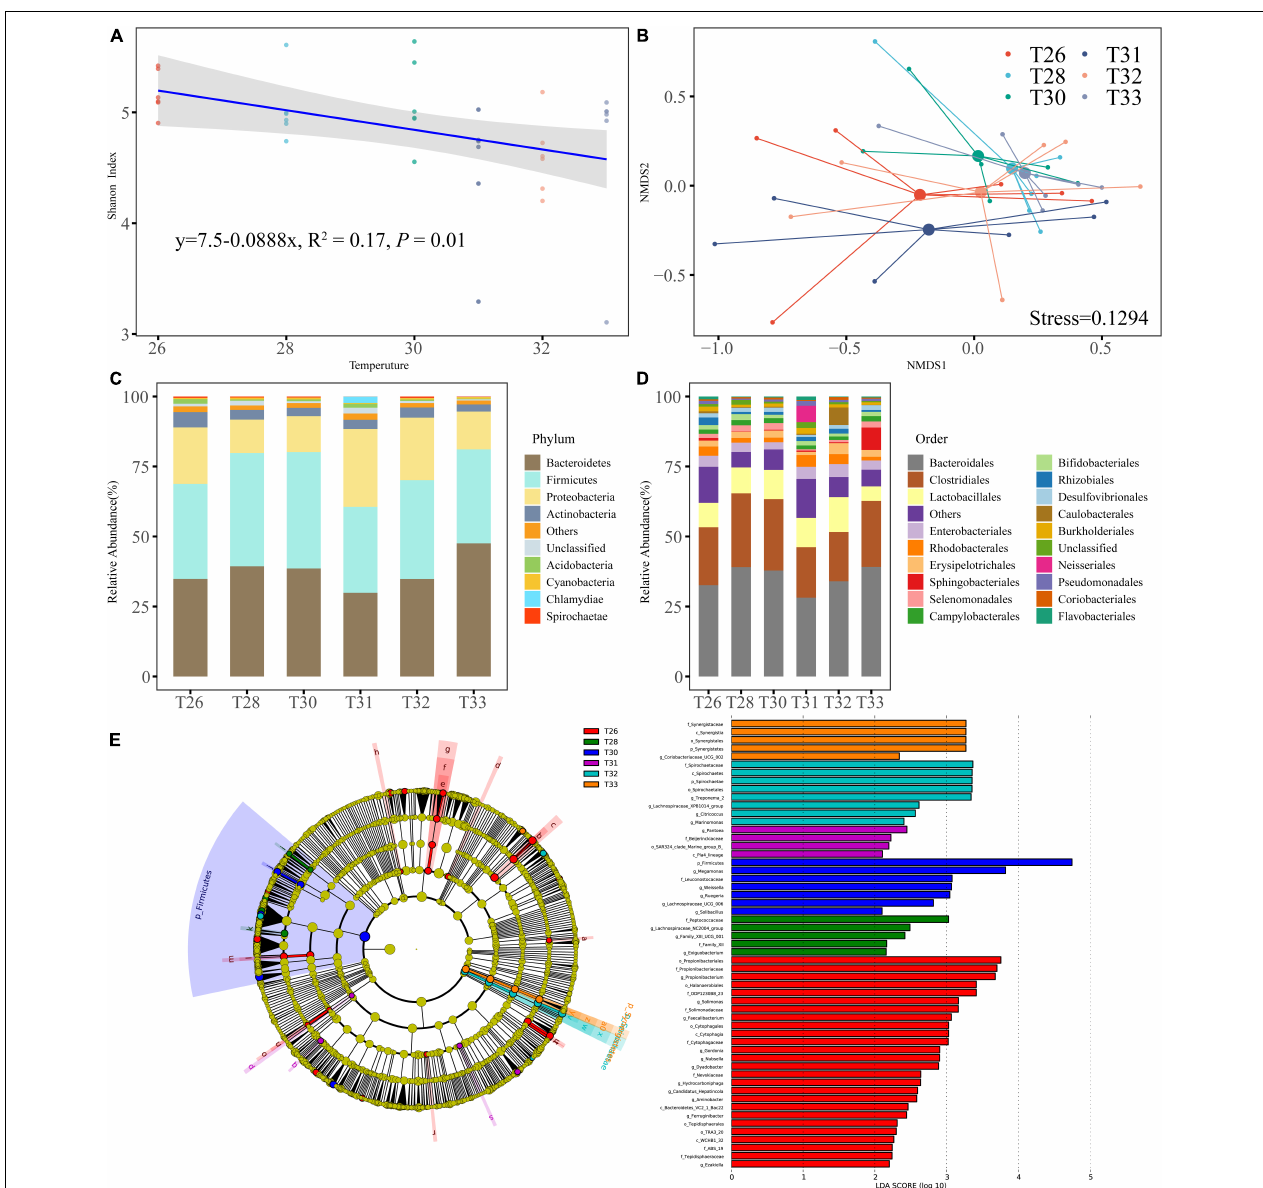
FIGURE 4 | The diversity and the community of coral-associated bacteria. (A) Shannon index of bacteria. (B) NMDS analysis performed at different temperatures on community composition dissimilarities (Bray-Curtis). (C) Microbial community composition of bacterial phyla in all samples. (D) Microbial community composition of bacterial order in all samples. (E) Indicator microbial groups at each treatment with the LDAvalues higher than